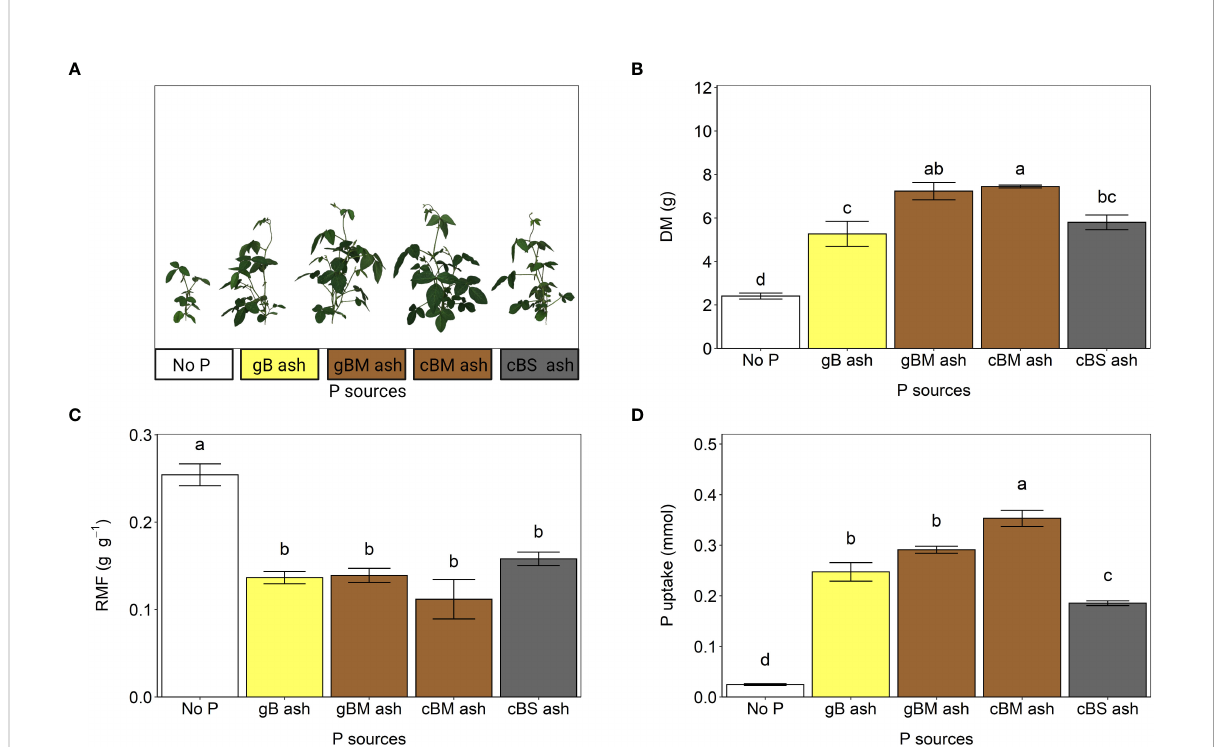
FIGURE 4 Fertilization effects of gB, gBM, cBM and cBS ashes on soybean (experiment 2). (A) Shoot phenotypes, (B) total plant dry mass (DM), (C) root mass fractions (RMF), and (D) uptakes of phosphorus (P) from the ashes. All values are given per plant. The error bars indicate standard errors of the means. Identical letters indicate no statistical differences between the fertilizer treatments (Tukey ’ s HSD test, p ≤ 0.05, n =